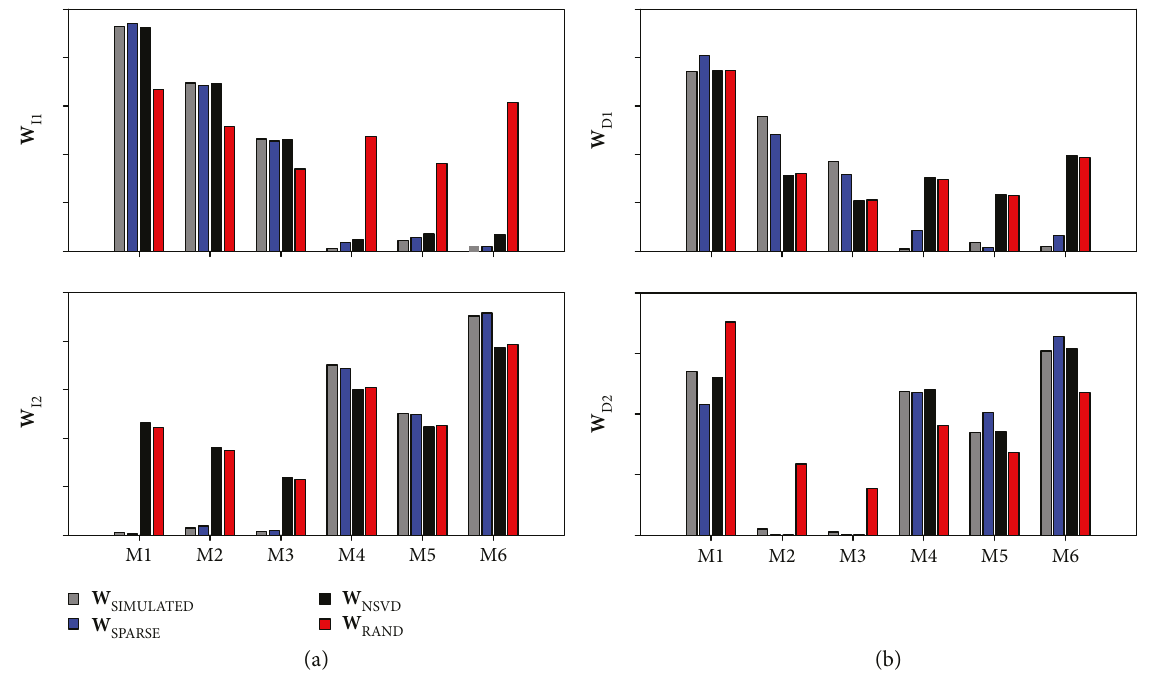
Figure 4: Example of synergy extraction with di ff erent initialization techniques with a correlation level of 0.9: (a) independent synergy vectors W W I ; (b) dependent synergy vectors D . Only SPARSE is able to accurately estimate